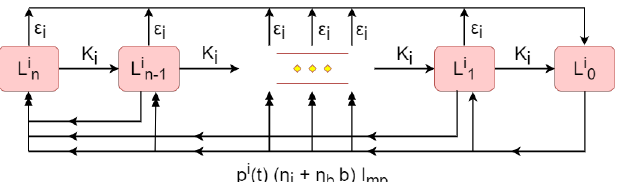
Figure 2. Flow diagram representation of the indoor environment. The multiple stages of contamina- tion L i for j = 0, . . . , n are denoted by round squares, which are connected by the black solid arrows, j indicating the incremental decay of contamination, environmental hygiene and total indoor shedding output of the herd. The double arrows denote the accumulated contamination input to the L i by all less contaminated stages L i , . . . L i 0 j − 1